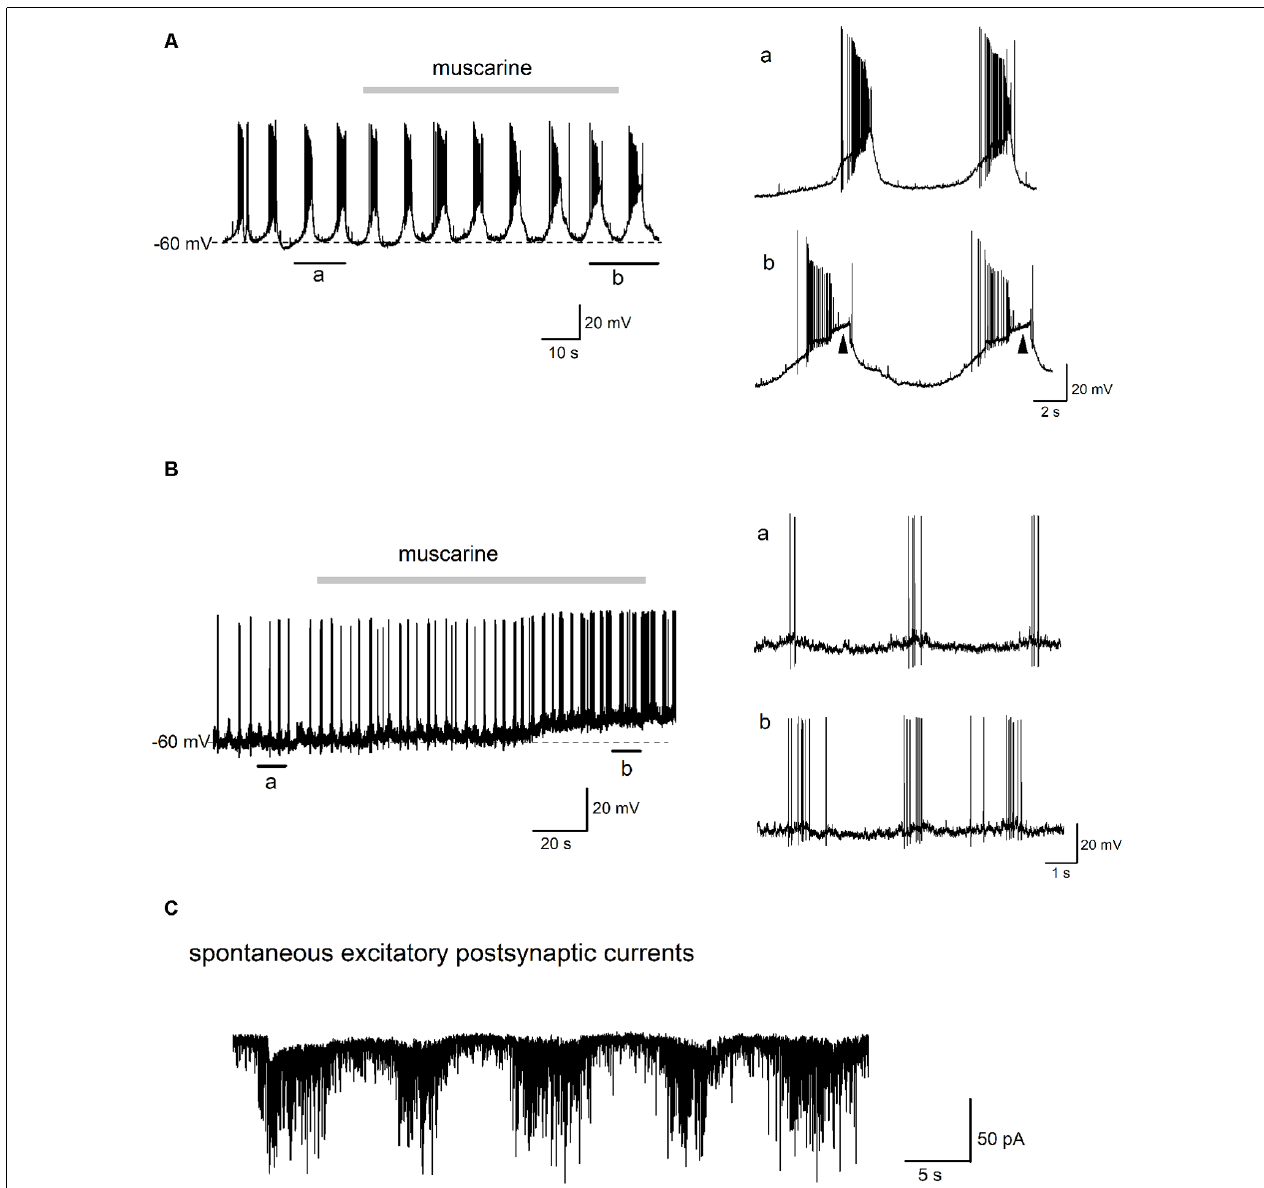
FIGURE 7 | Effect of muscarine on the “burst-like” firing glycinergic neurons in the preBötC. Traces in (A) show the effects of muscarine (10 µ M) recorded in a “burst-like” glycinergic neuron. This cell discharged in a rhythmic “burst-like” pattern consisting of alternating bursts of action potentials (APs) interspersed with strong membrane hyperpolarization and cessation of firing. Two “bursts” of rhythmic discharges before and during muscarine (indicated by black bars underneath the trace) are enlarged for closer inspection on the right. Note that muscarine had such a strong excitatory effect on this neuron that it induced a depolarization block during the burst (arrowheads). Traces in (B) are from a different rhythmically firing “burst-like” neuron, whose morphology is shown in Figure 1B (right). This neuron fired brief, rhythmic “bursts” of 3–5 APs under control conditions as illustrated on a larger time scale on the right. Note the lack of a large depolarizing envelope as in panel (A) . Muscarine application depolarized this neuron and increased the burst frequency and number of spikes per burst. Trace in (C) is from an EGFP-positive glycinergic neuron recorded in voltage-clamp mode at − 70 mV. Note the rhythmic bursts of spontaneous excitatory postsynaptic currents (EPSCs), which were recorded in the presence of picrotoxin (100 µ M) and strychnine (10 µ M) to block fast GABA- and glycinergic inputs, respectively.